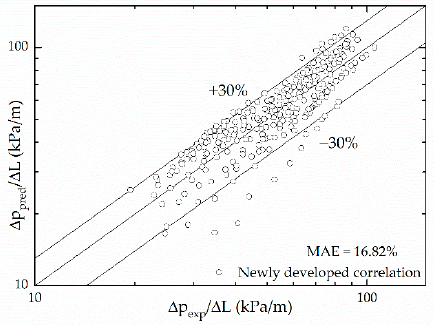
Figure 11. Comparison of pressure frictional pressure drop data with predictions of the separated flow correlation with the new C.